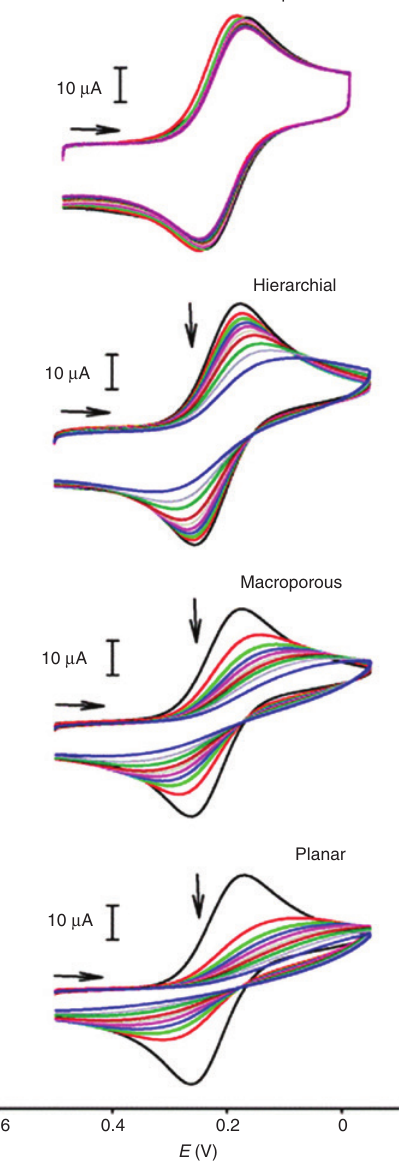
Figure 8: Cyclic voltammograms at nanoporous, hierarchical, macroporous, and planar gold electrodes in a solution of ferricyanide and bovine serum